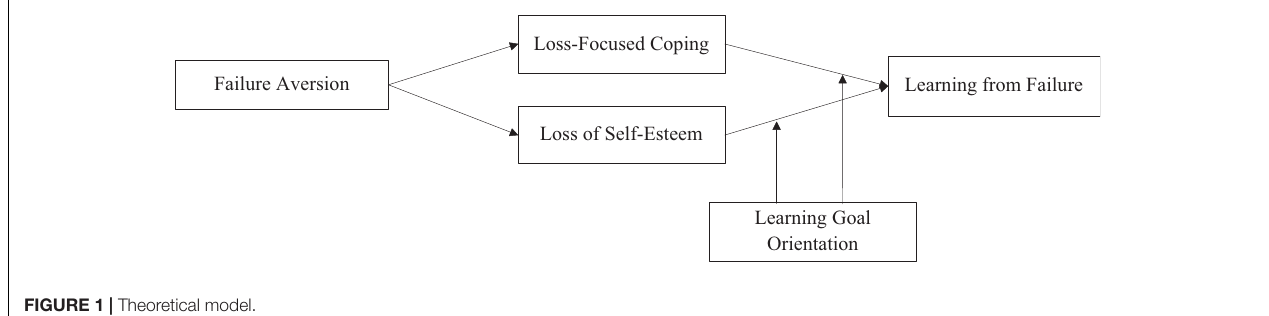
FIGURE 1 | Theoretical